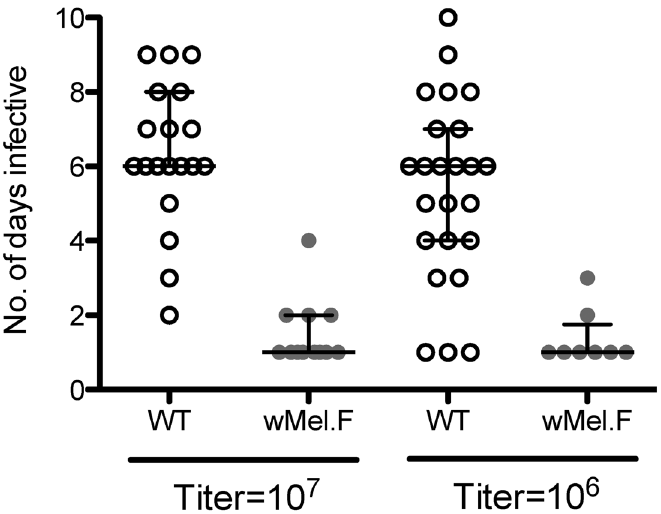
Fig 2. Number of days infective saliva was detected for WT (white) and w Mel.F mosquitoes (grey). Bars depict medians ± interquartile range. Mosquitoes were orally infected with either 10 7 or 10 6 PFU/ml of DENV. Each data point represents a pool of 10